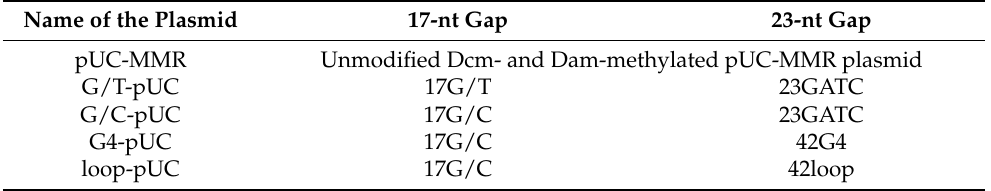
Table 2. Combinations of oligonucleotides inserted into double-gapped Dcm- and Dam-methylated pUC plasmid and names of resulting